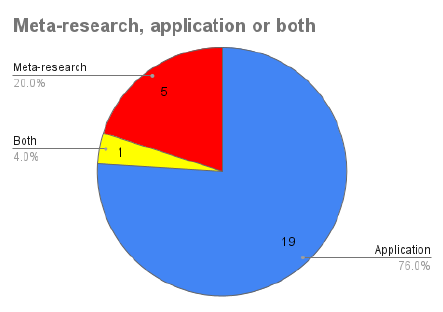
Figure 3. Focus of the research ethical association. Figure 3 represents the information extracted by